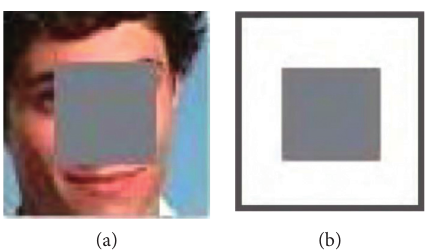
Figure 6: Damaged image y and binary mask image M . (a) y , (b) M .